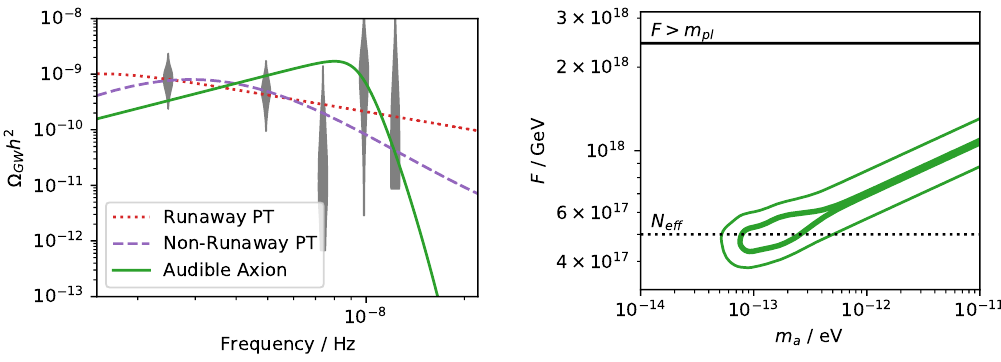
Figure 2: Left: Signal of the best fits of a runaway and a non-runaway phase transi- tion as well as an audible axion compared to the first frequency bins of NANOGrav h 2 plane. Right: 1 σ and 2 σ regions in the F - m in the frequency- Ω plane parame- GW a terizing the audible axion. The horizontal lines indicate the bounds originating from the decay constant F having to be smaller than the Planck mass m and from the pl dark photon relic density not violating the bounds on N eff